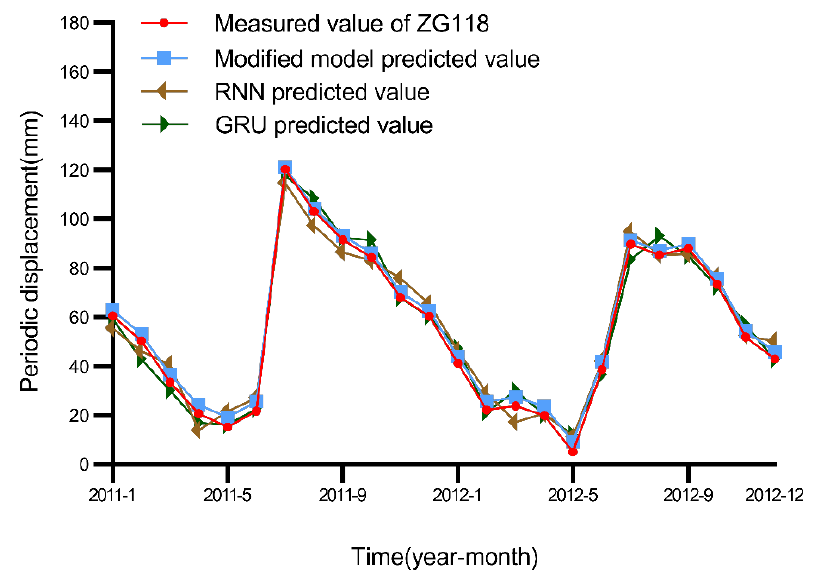
Figure 21. Periodic displacement predicted results of ZG118 using LSTM-FC, RNN and GRU models.